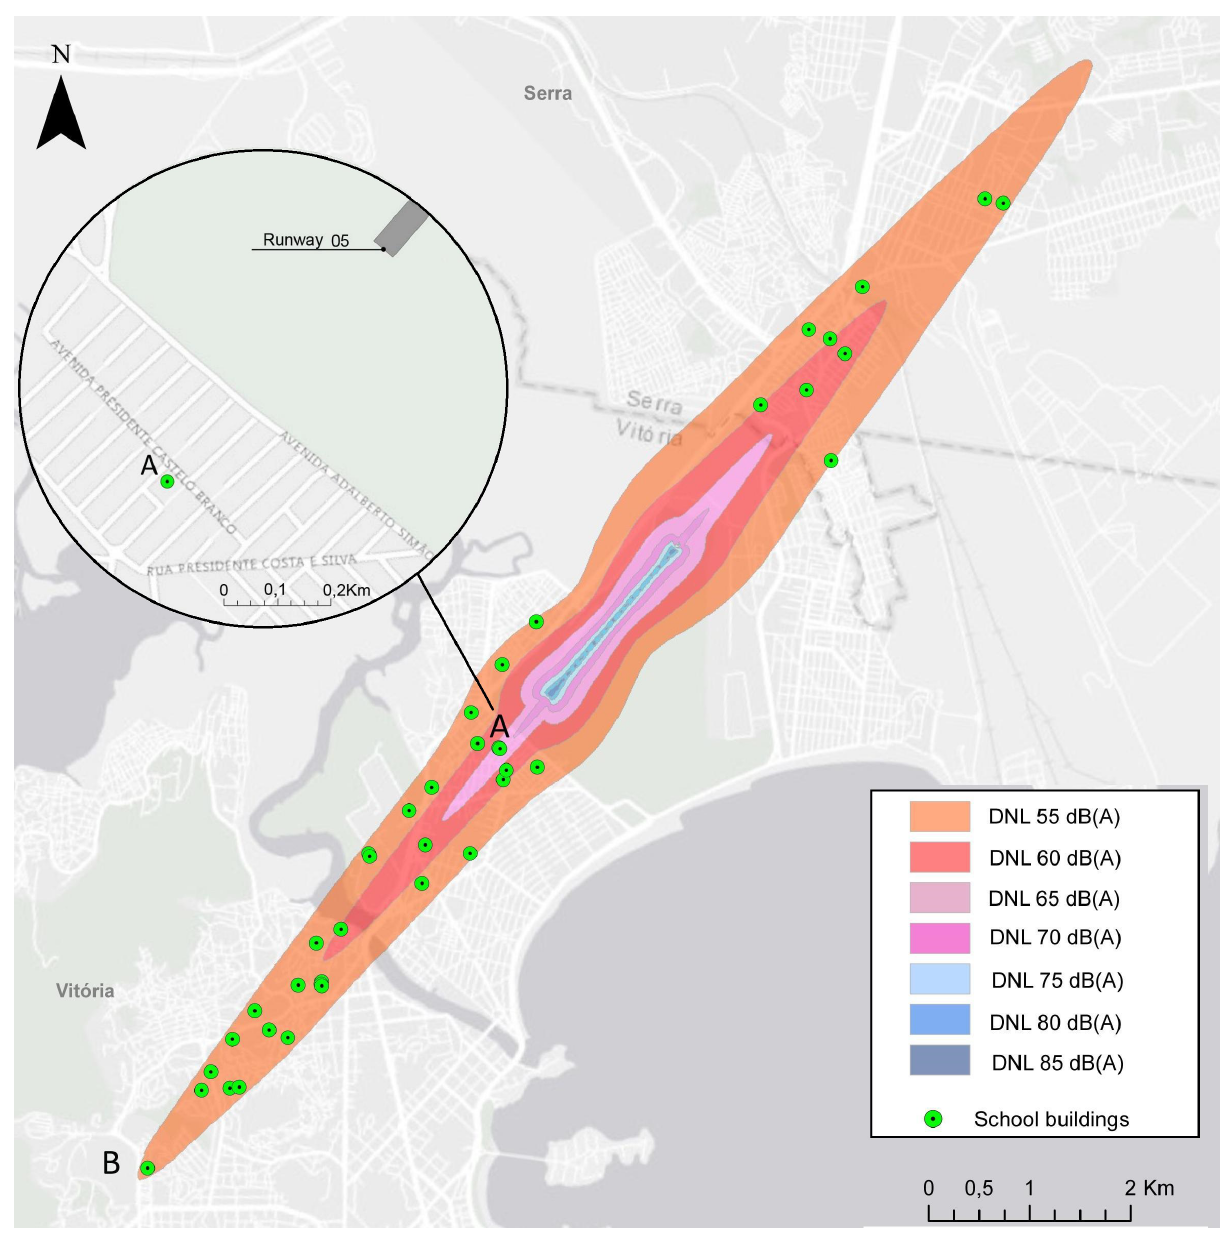
Figure 2: Identification of critical receivers. School “A” is about 600 m distance from runaway. School “B” is the furthest from the airport site, inside DNL 55